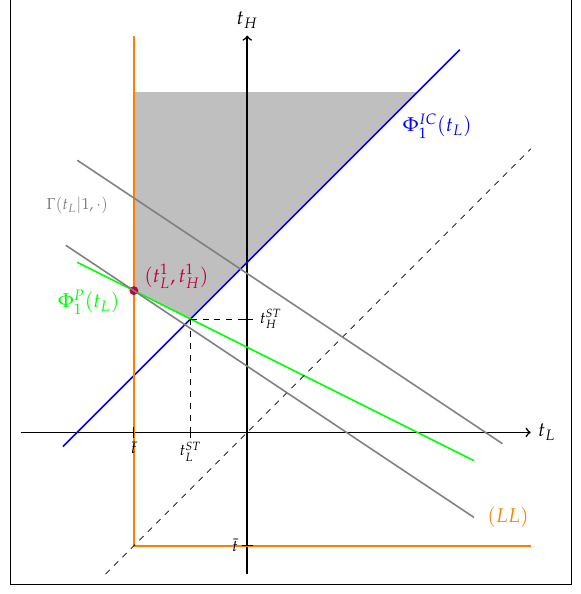
Figure 2. e = 1 and ¯ t < t ST